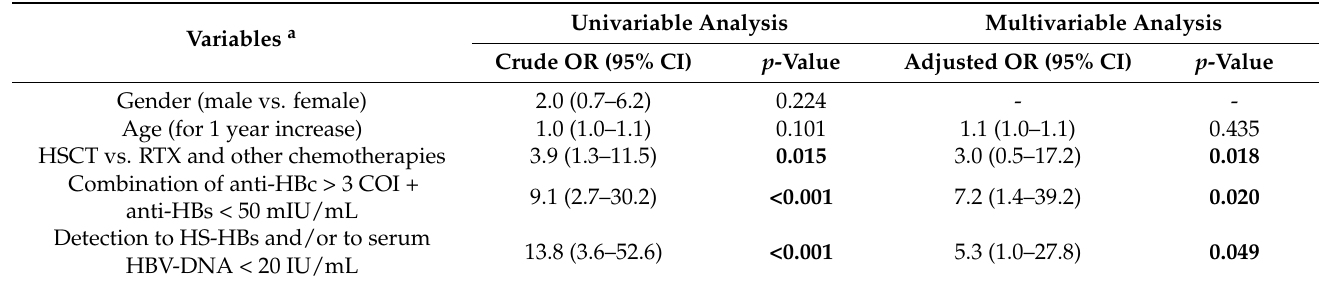
Table 3. Factors associated with HBV-R by multivariable logistic regression